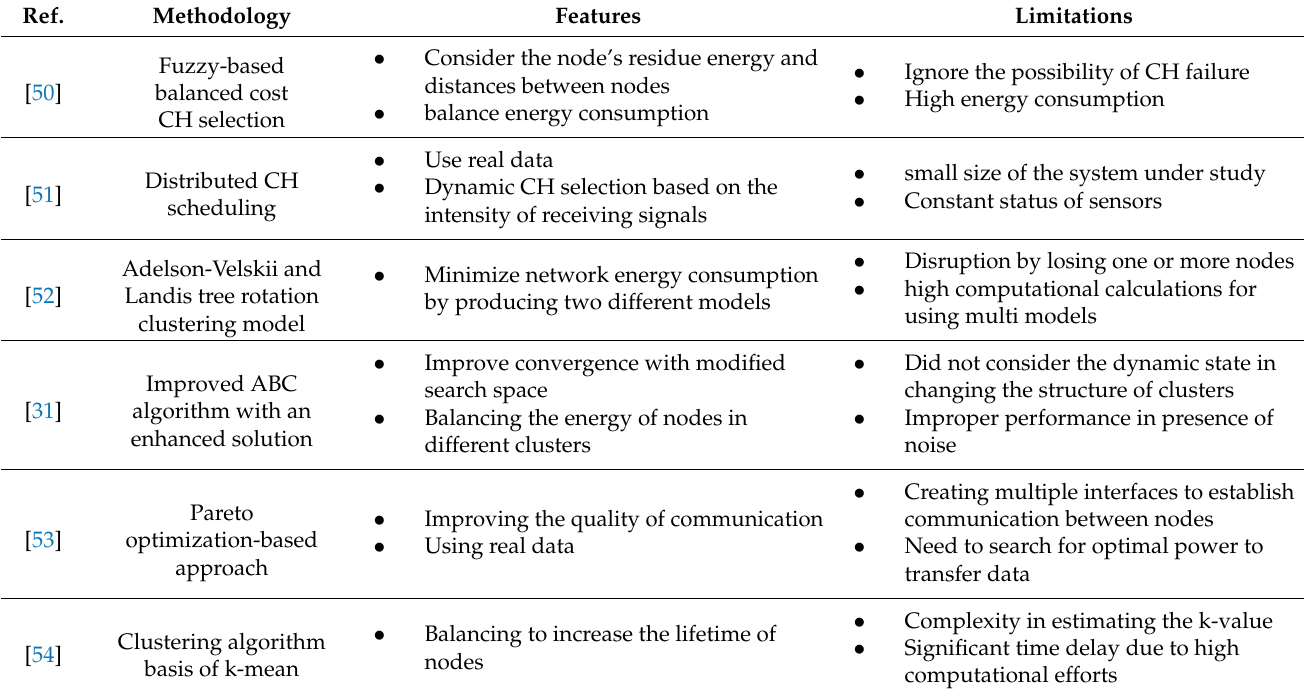
Table 3. Comparison of different issues of clustering